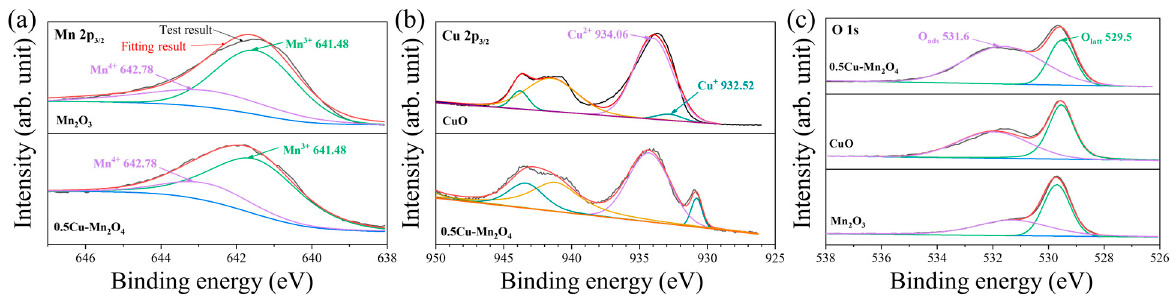
Figure 6. XPS spectra of Mn 2p3/2 ( a ), Cu 2p3/2 ( b ), and O1s ( c ).